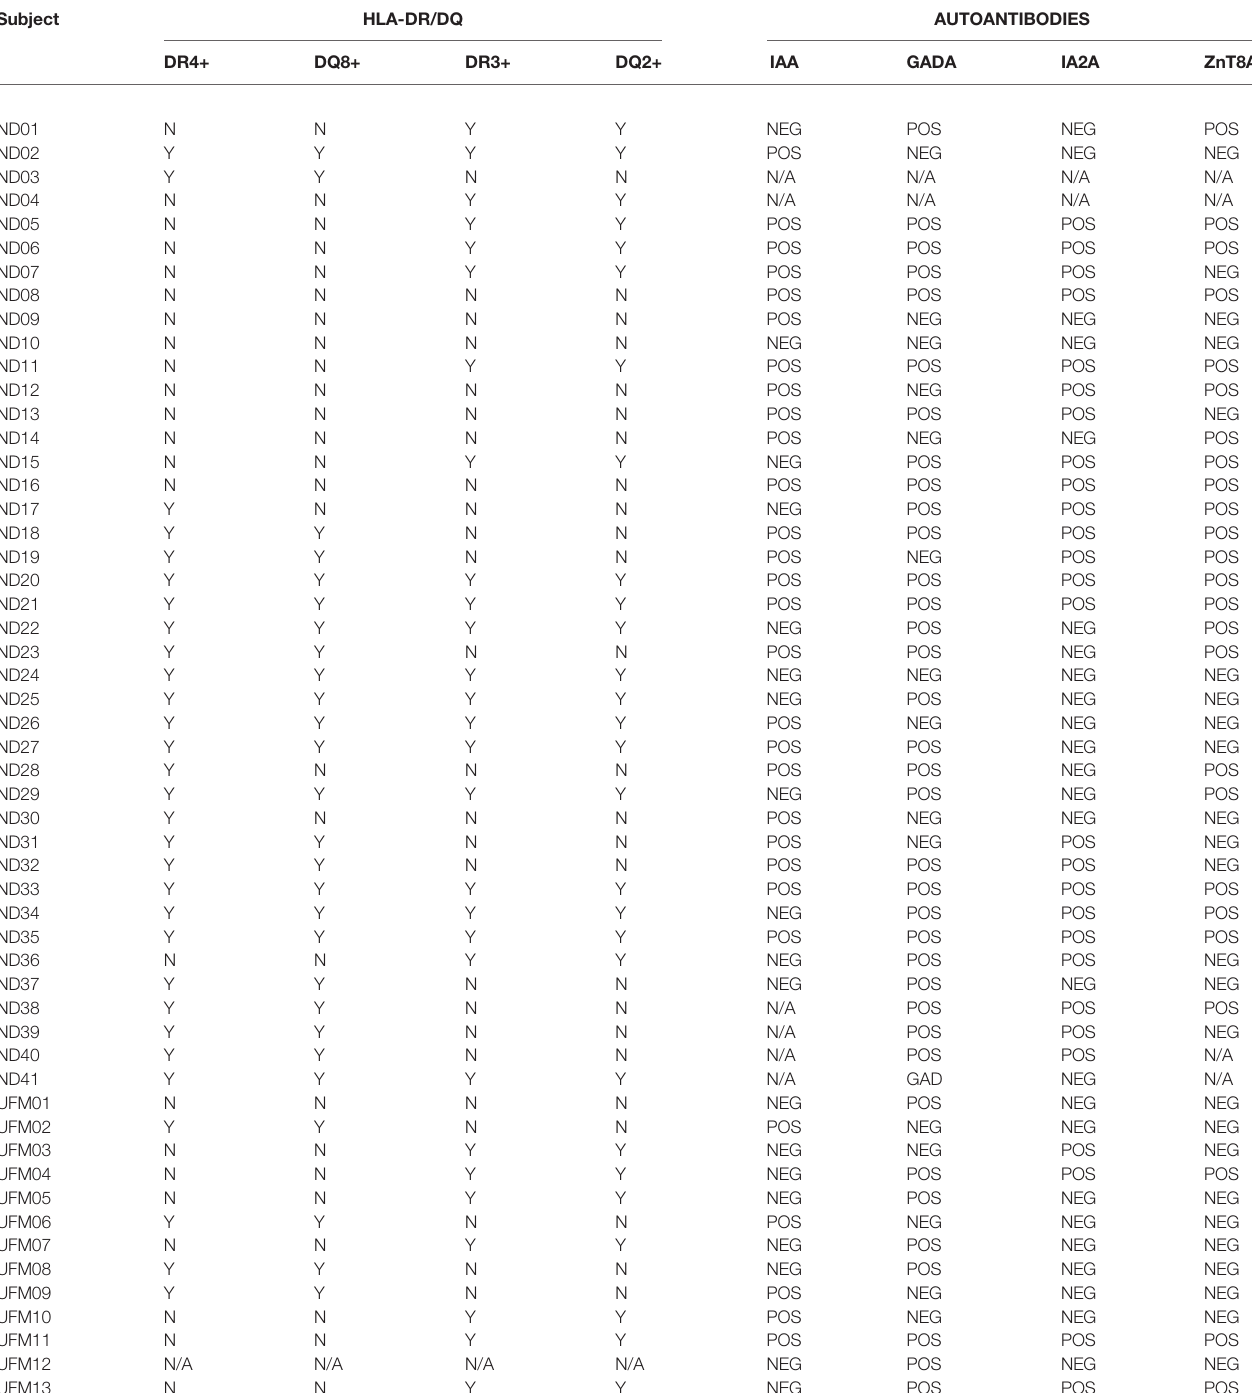
TABLE 1 | HLA and autoantibody status of subjects with type 1 diabetes and unaffected family members